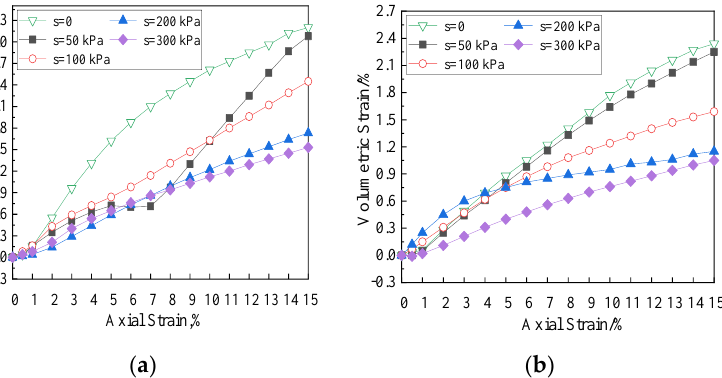
Figure 12. Effects of matric suction on volumetric strain vs. axial strain curves (net confining pressure = 100 kPa). ( a ) Fiber length = 6 mm, ( b ) fiber length = 19 mm.